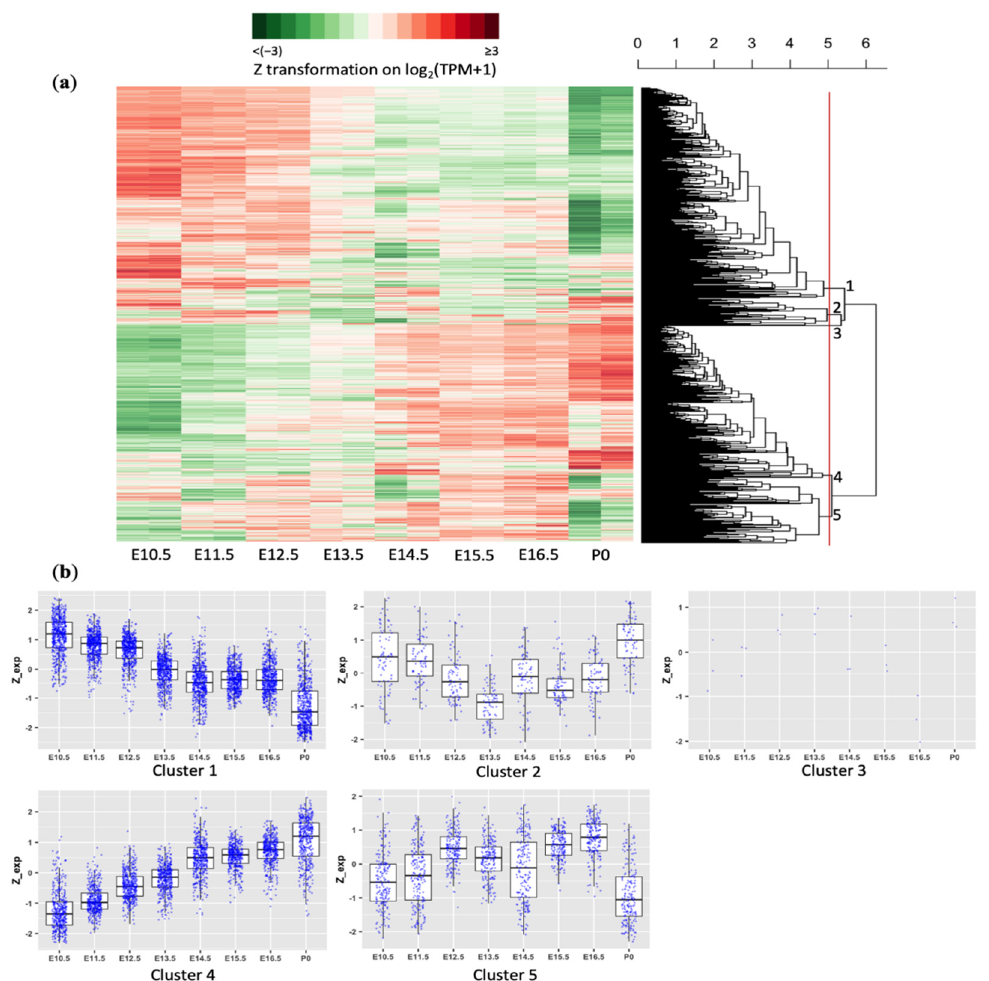
Figure 1. Expression dynamic of apoptosis − related genes during mouse forebrain development: ( a ) Hierarchical clustering and expression heatmap of apoptosis − related genes across development ages (E10.5, E11.5, E12.5, E13.5, E14.5, E15.5, E16.5, P0). Clusters are defined by the red line crossing the dendrogram. Cluster numbers are noted next to each cluster tree. ( b ) mRNA expression of five clusters defined in ( a ). The expression level of each gene was log − transformed (log 2 (TPM + 1)) and then Z − score normalized (i.e., centered by the mean and divided by the standard deviation across different development ages).